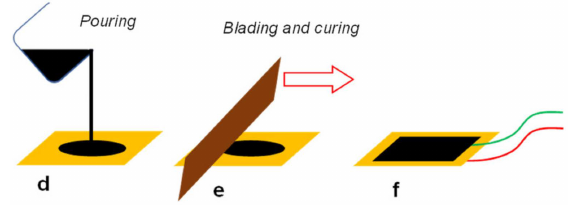
Figure 4. CB electrode deposition and curing with signal cables.